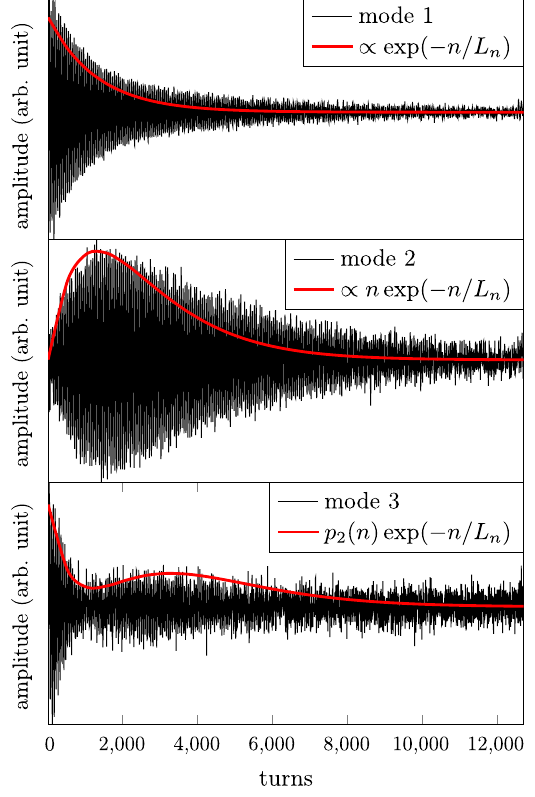
FIG. 6. The first three principal components of the oscillation after the injection. The red auxiliary lines illustrate that the envelopes of the temporal vectors satisfy the general solution (13). L n is a constant and p 2 ð n Þ is a quadratic polynomial of the turn number n